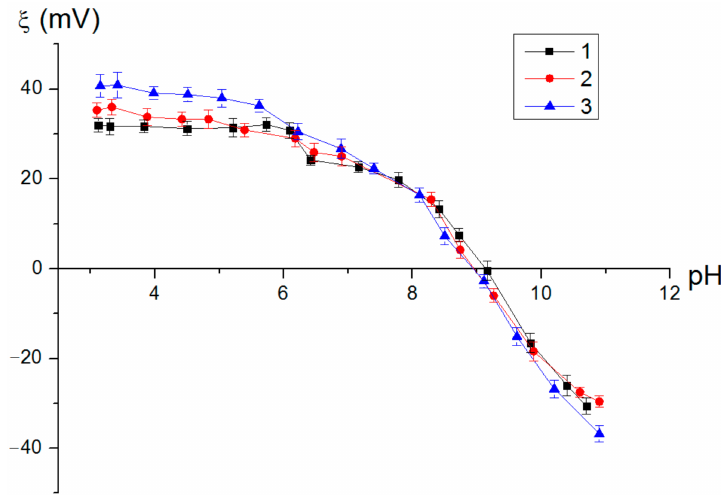
Figure 6. Dependence of the zeta potential value of nanosheets (1), nanoplates (2) and nanorods (3) on the pH value of the medium.